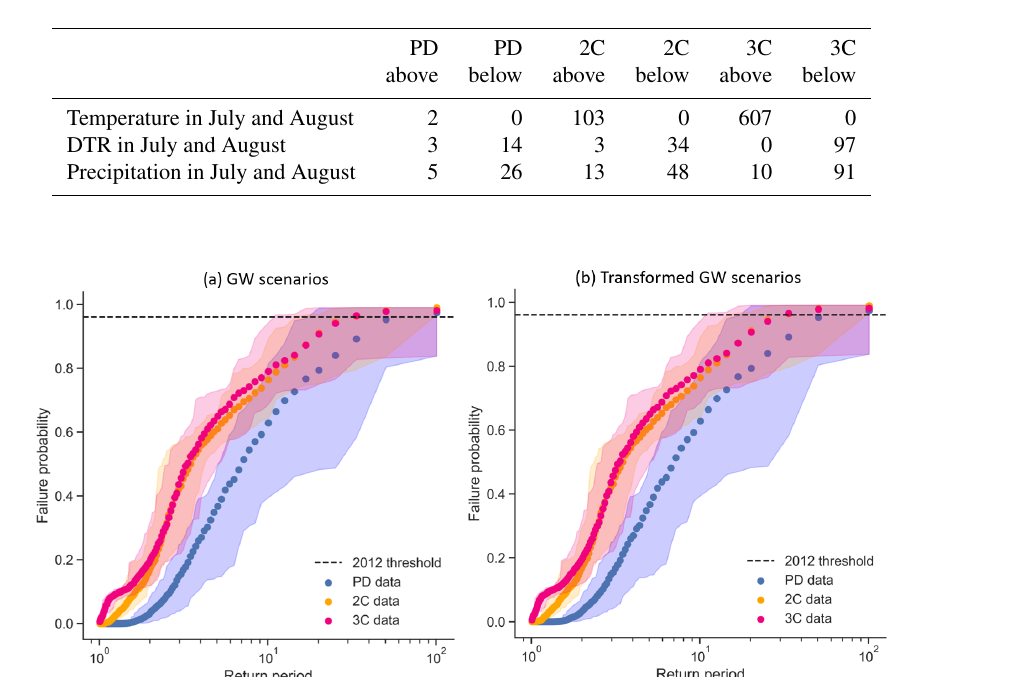
Figure B1. (a) Random forest model failure probabilities for PD (blue), 2C (orange) and 3C (pink); panel (b) is the same as (a) but for values adjusted to the training data limits. Dots show the 20-member mean; shading shows the range across the 20 members. The dashed line represents the failure probability of the 2012 season predicted by the